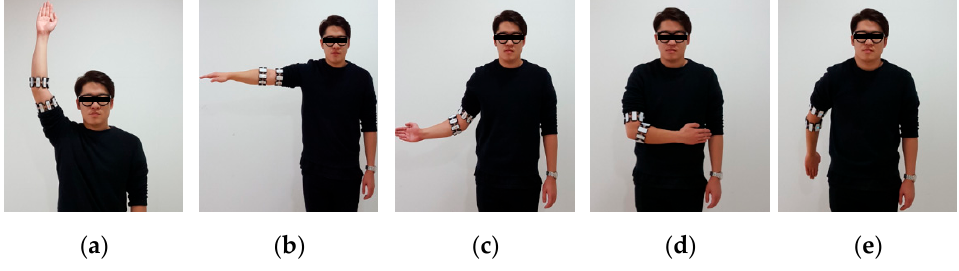
Figure 8. This is a figure, the five defined postures. ( a ) Screen shoots of Flexion posture; ( b ) Screen shoots of Extension posture; ( c ) Screen shoots of Abduction posture; ( d ) Screen shoots of Internal posture; and, ( e ) Screen shoots of External posture.